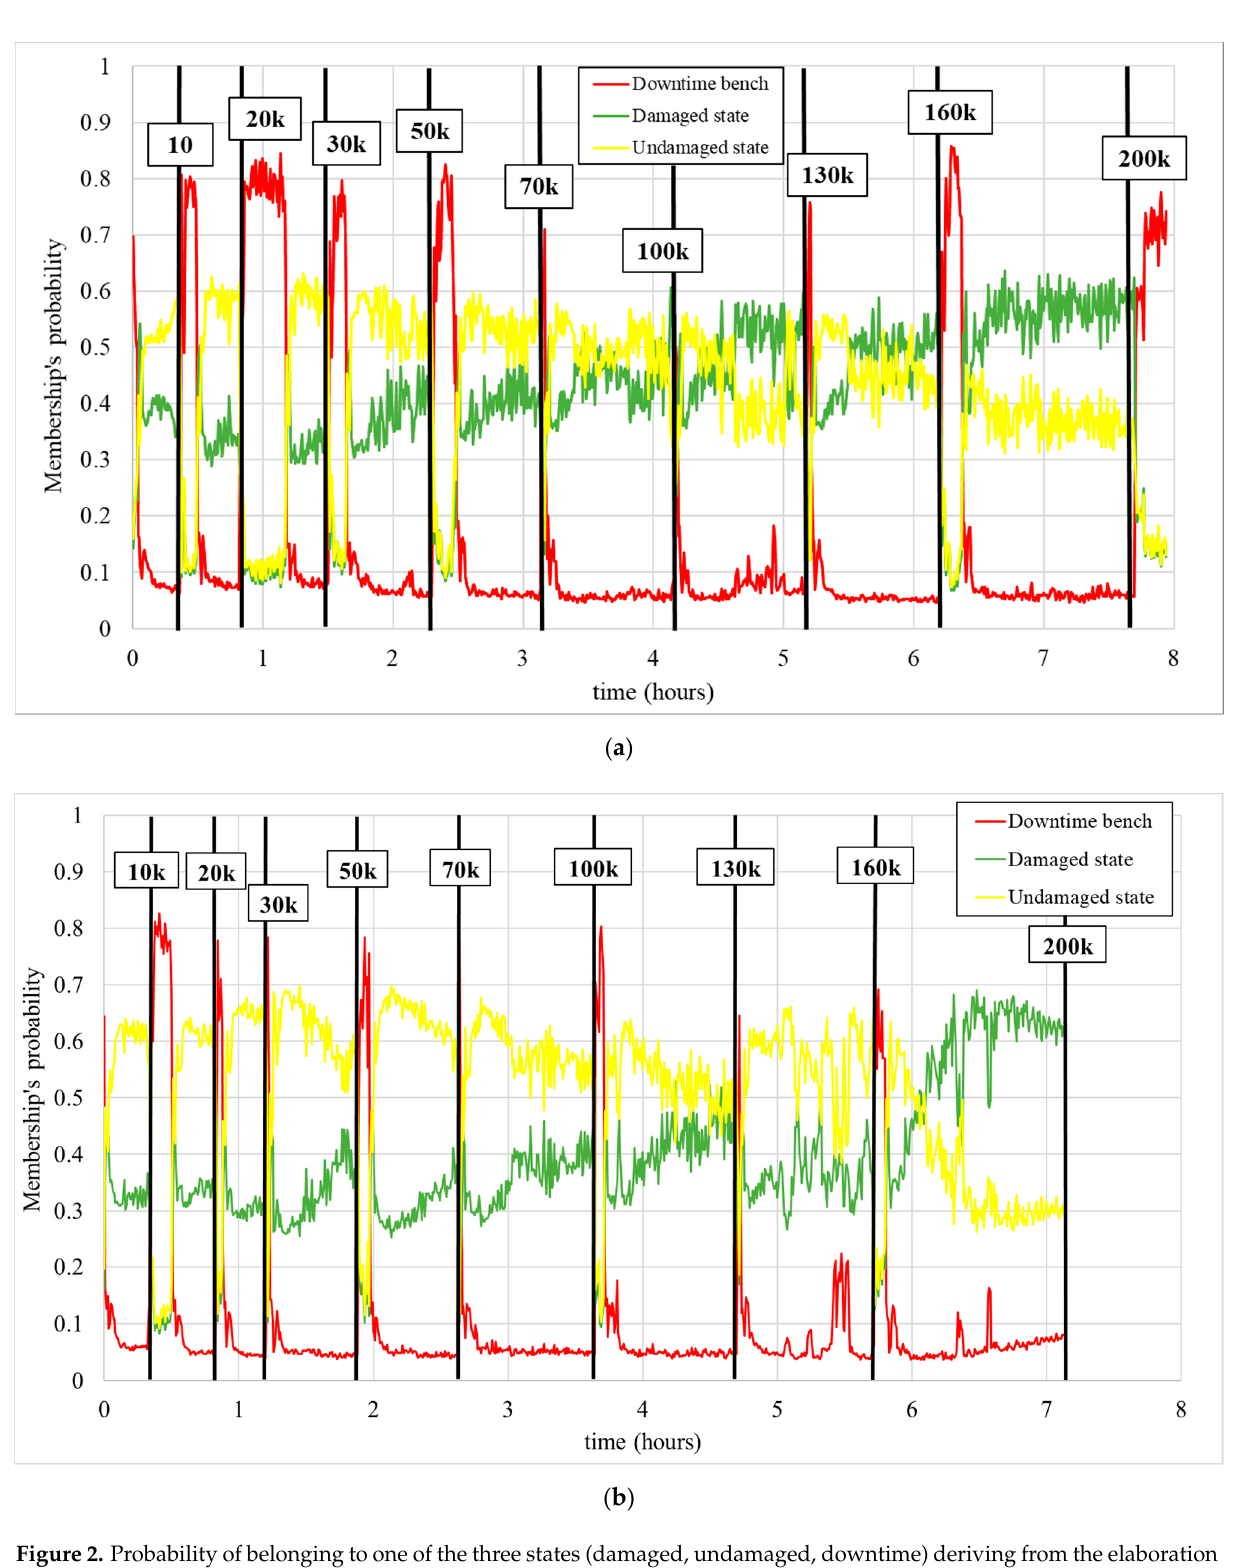
Figure 2. Probability of belonging to one of the three states (damaged, undamaged, downtime) deriving from the elaboration of the datasets carried out with k-means for the stepwise training tests T01 ( a ) and T02 ( b ). By analyzing the stepwise tests (Figure 2), three clusters were recognized from the k- means algorithm: cluster 1 (yellow) represents the undamaged state and it is the most frequently found during all the tests; cluster 2 (green) is associated with the damaged state